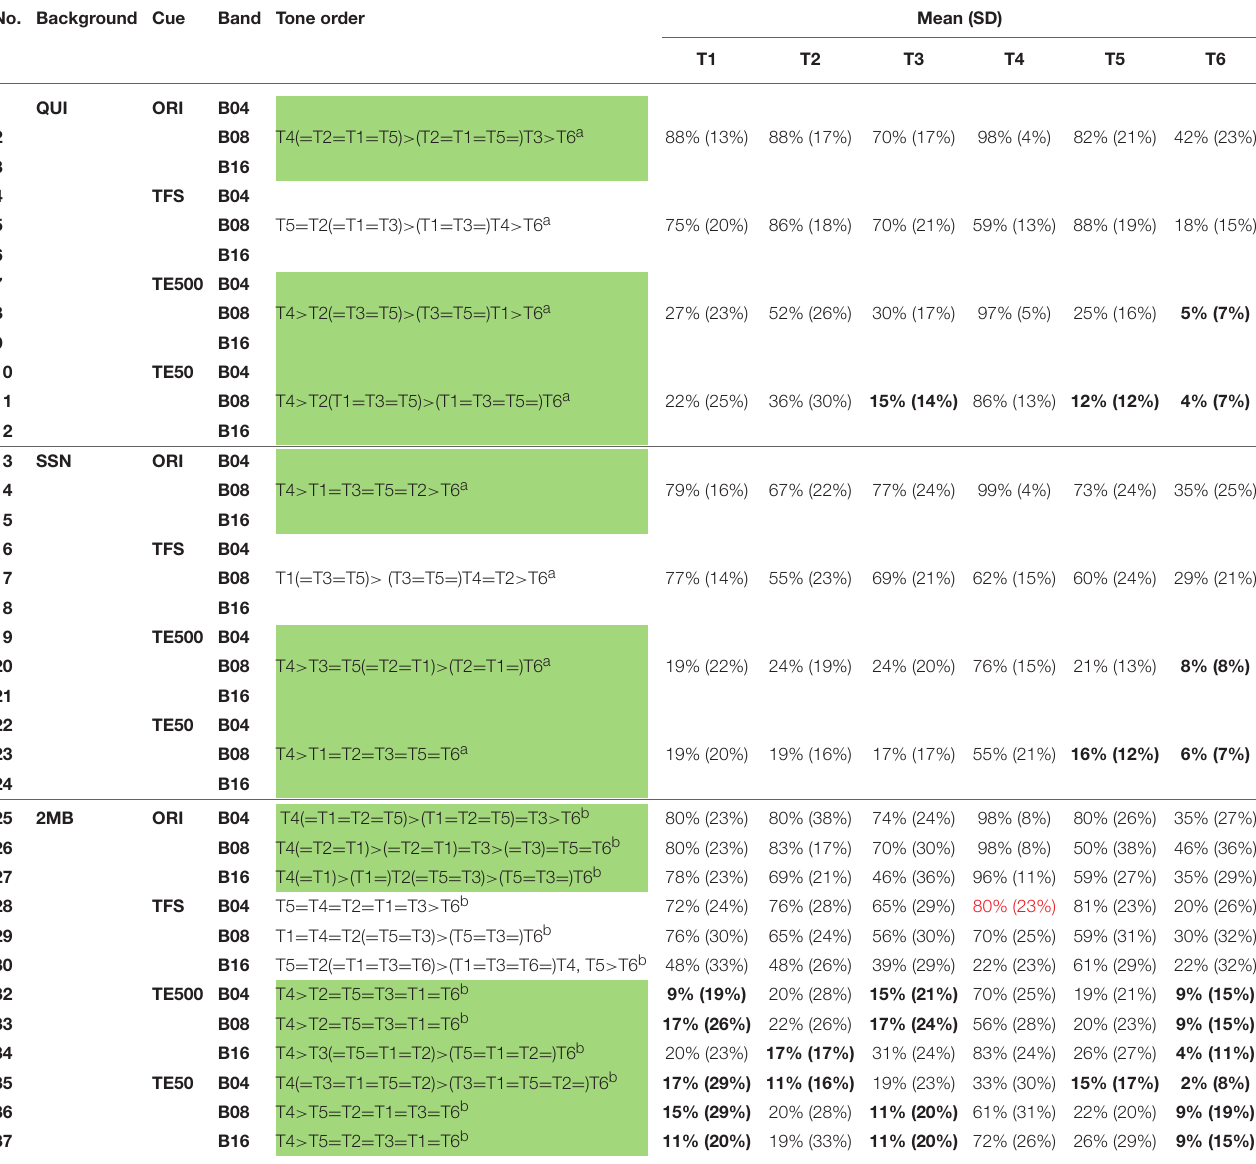
TABLE 6 | Results of pairwise comparisons on tone accuracy in Cues * Bands * Tones three-way repeated measures ANOVA by Backgrounds. No. Background